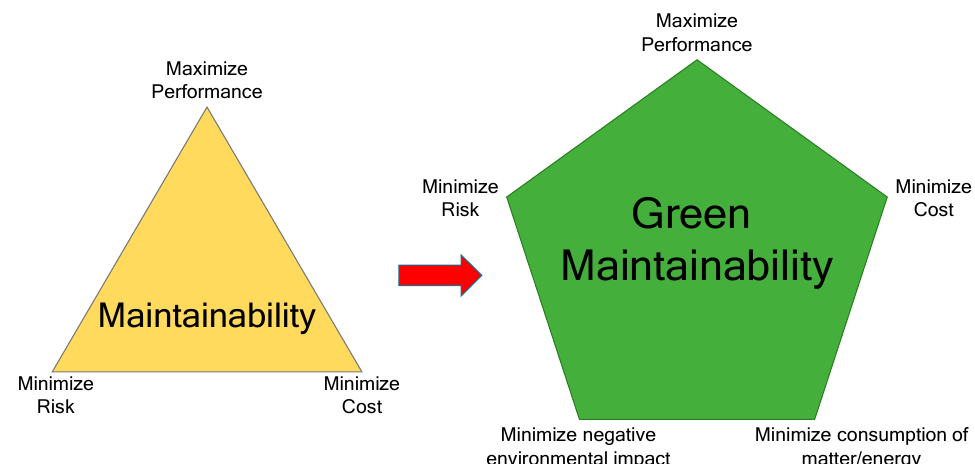
Figure 1. Definitions of maintainability and Green Maintainability.